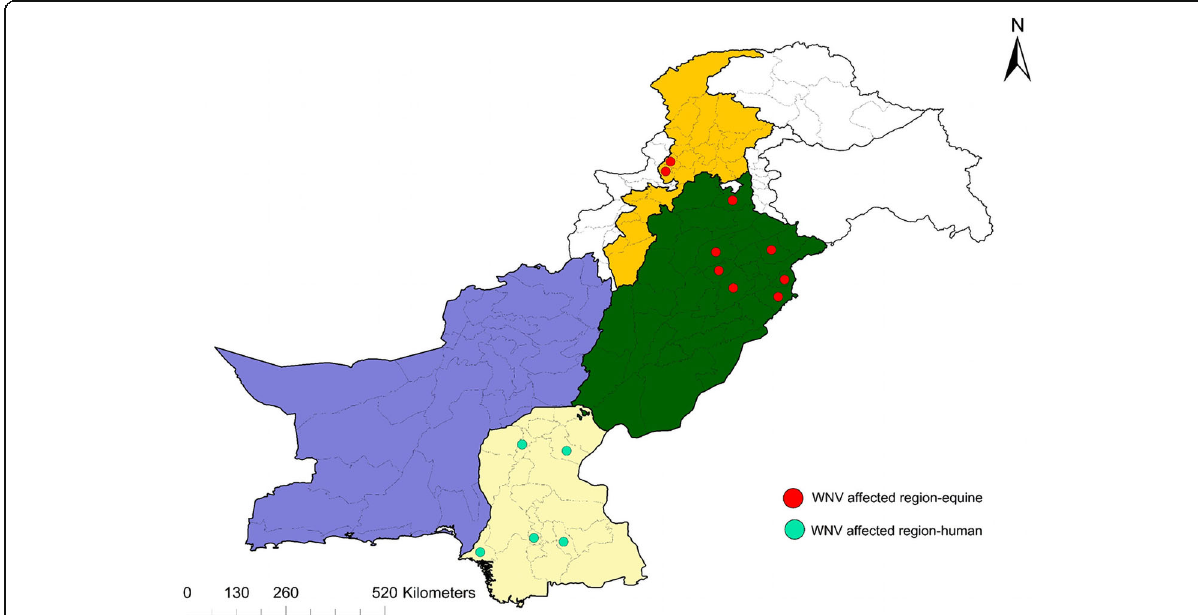
Fig. 4 West Nile virus ( WNV) cases of equines and humans reported in different regions of Pakistan (Zohaib et al. 2019; Zohaib et al. 2015; BURNEY and Munir 1966; Hayes et al. 1982; Khan et al. 2018). Map was created by ArcMap10.3 software (http://desktop.arcgis.com/en/arcmap/1